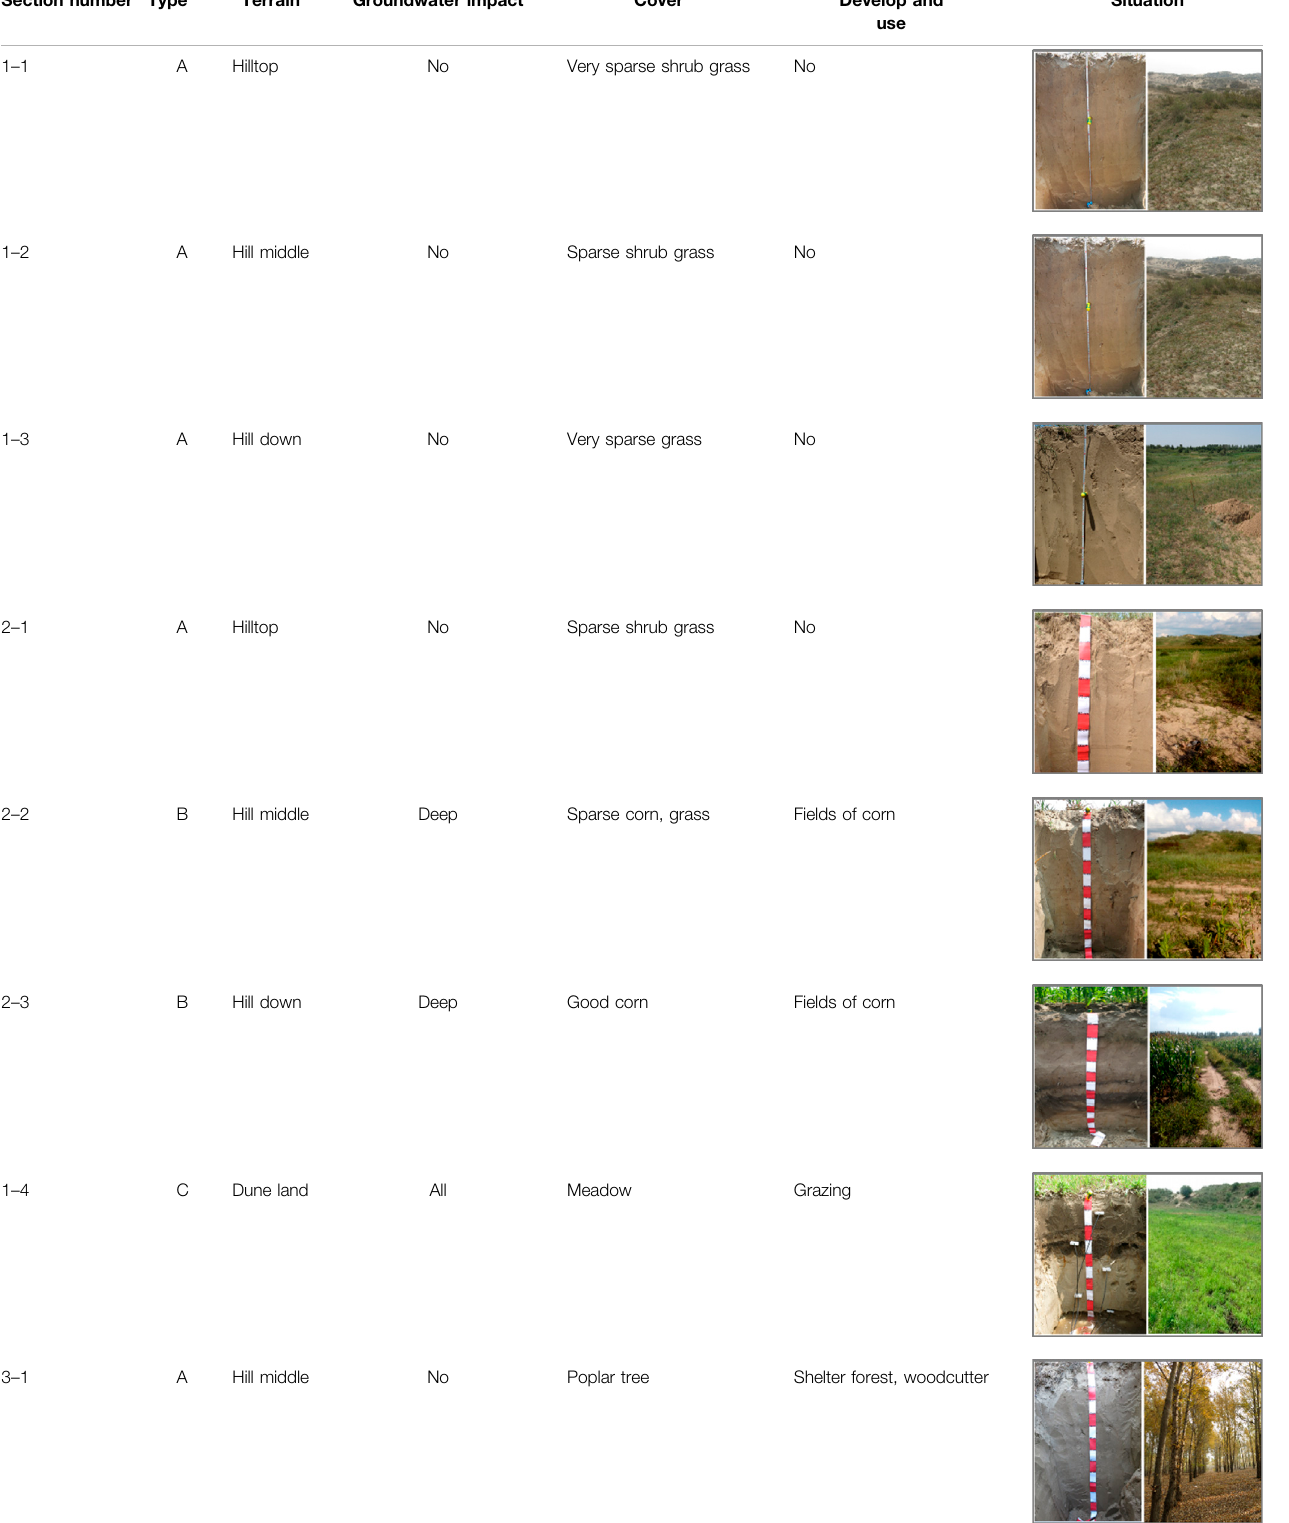
TABLE 1 | Summary table of water observation sampling points. Section number